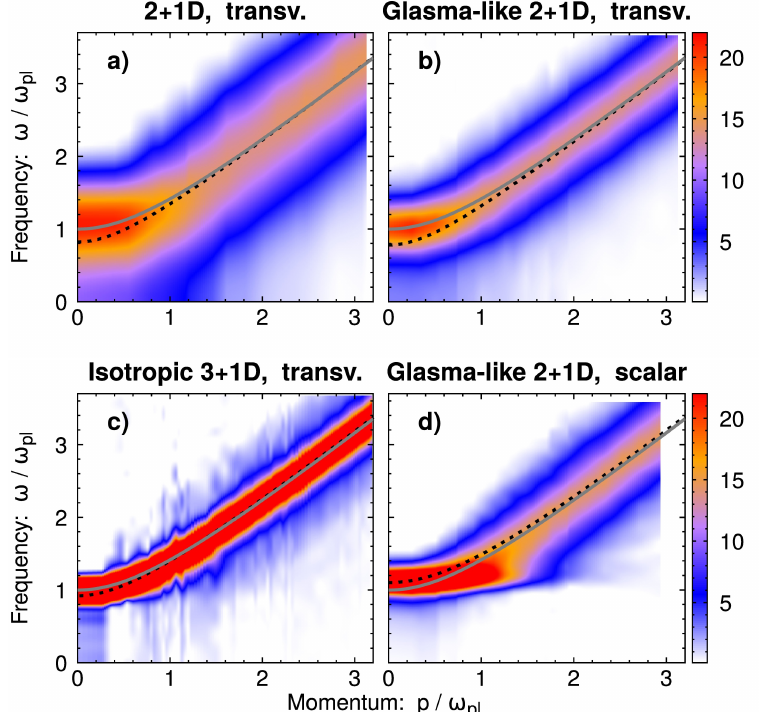
Figure 1 . The extracted and normalized transverse statistical correlation function h EE i T ( t, ω, p ) / h EE i T ( t, ∆ t =0 , p ) is shown for a) the 2 + 1 dimensional theory, b) for the Glasma- like theory and c) for an isotropic 3 + 1 dimensional system. Additionally, we show the scalar correlator h ππ i ( t, ω, p ) / h ππ i ( t, ∆ t =0 , p ) of the Glasma-like system in d). Note that all amplitudes have been cut off at the same fixed value 22 /Q corresponding to the red region. For comparison, we added the HTL dispersion relations ω HTL ( p ) as black dashed lines and a relativistic dispersion T/φ q + p 2 as a continuous gray line with the extracted values for ω as in the ω rel ( p ) = ω 2 pl pl